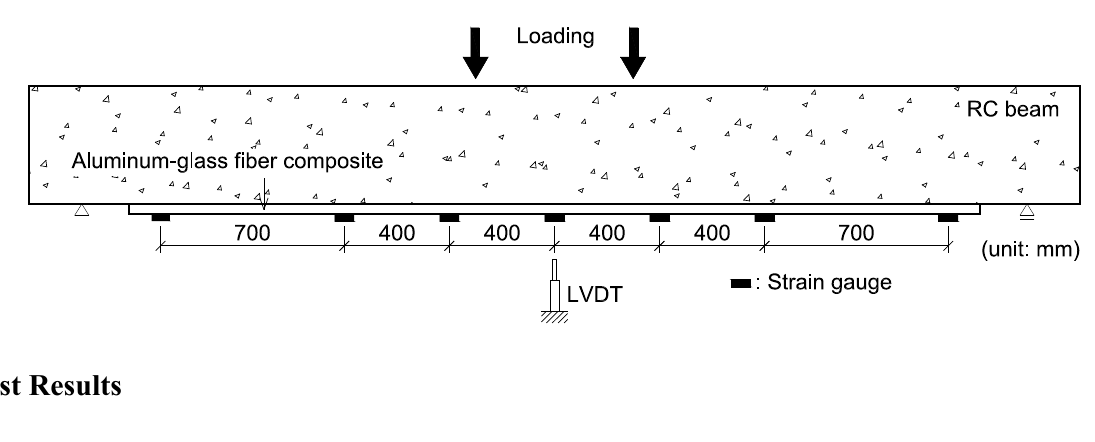
Figure 5. Four-point bending test setup.